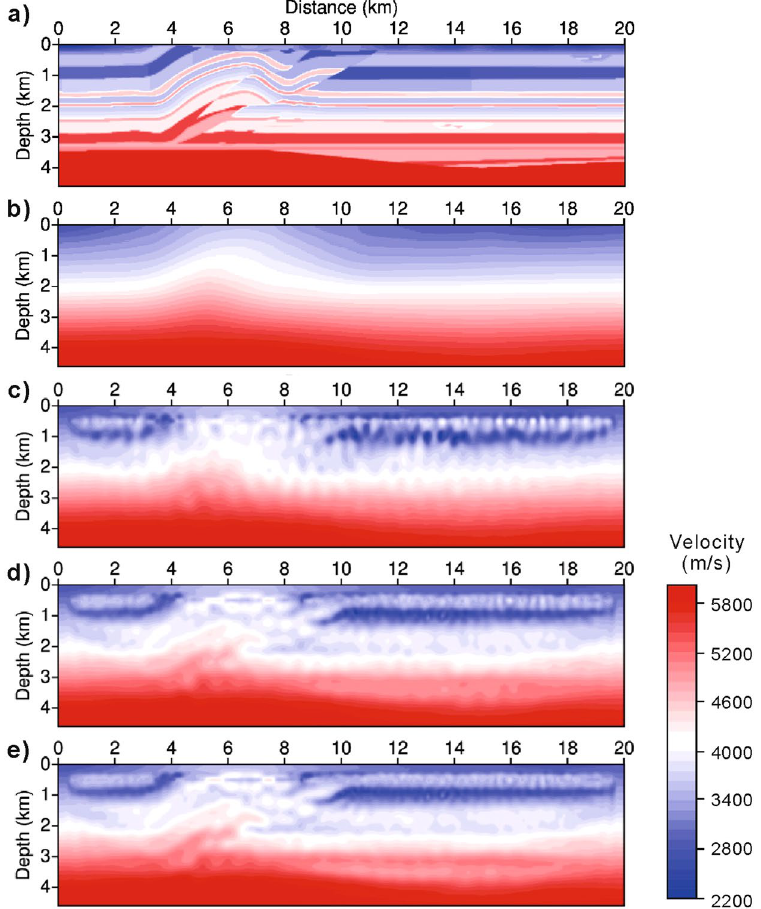
Figure 2. Randomness vs. crosstalk. ( a ) An overthrust model. ( b ) The initial model for FWI. ( c , d , e ) The inversion results at the 10 th , 50 th and 100 th iterations, using the data set of the lowest frequency band (2 − 4 Hz). Crosstalk noise is gradually suppressed along with the increased randomness in the restarted L-BFGS